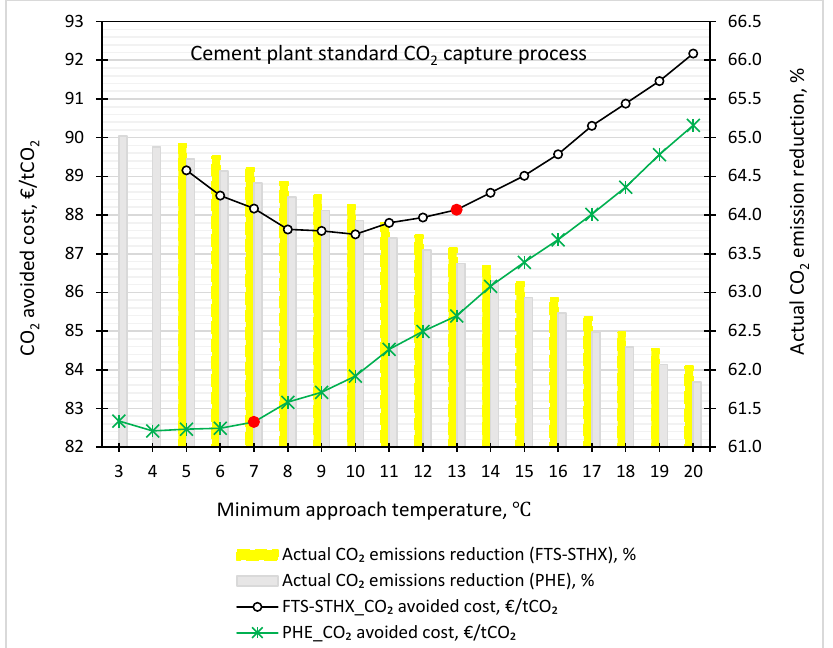
Figure 13. Energy and heat exchanger costs trade-off analysis at different ∆ T min for different heat exchanger types in a standard CO 2 capture from cement flue gas with consideration of actual CO 2 emissions reduction (red dot is the ∆ T min where optimum CO 2 capture cost is achieved, which can be different from the CO 2 avoided cost optimum the ∆ T min